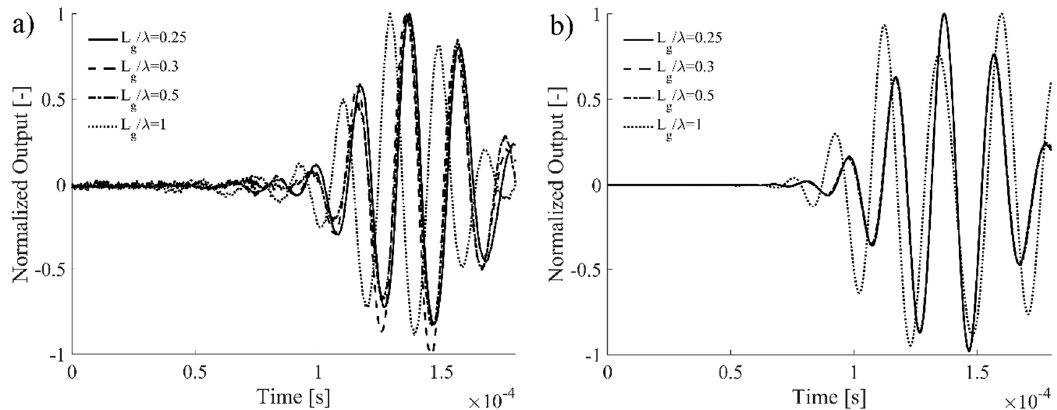
Figure 9. Gauge length effect on the Lamb wave signal acquired by the FOC sensor: ( a ) experimental results and ( b ) numerical simulation. Results are presented as a function of L g / λ